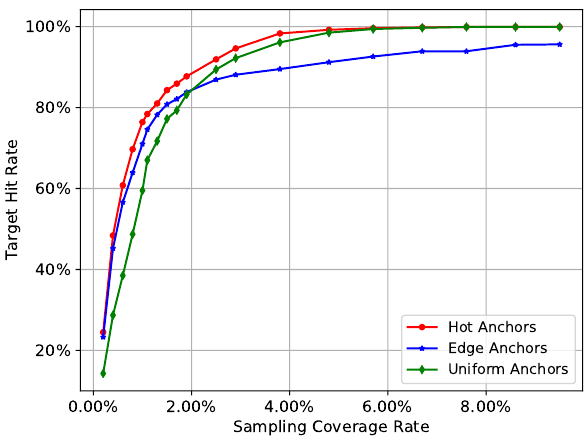
Figure 3. The target hit rate curves of three sampling methods. Hit distance threshold d 0 is